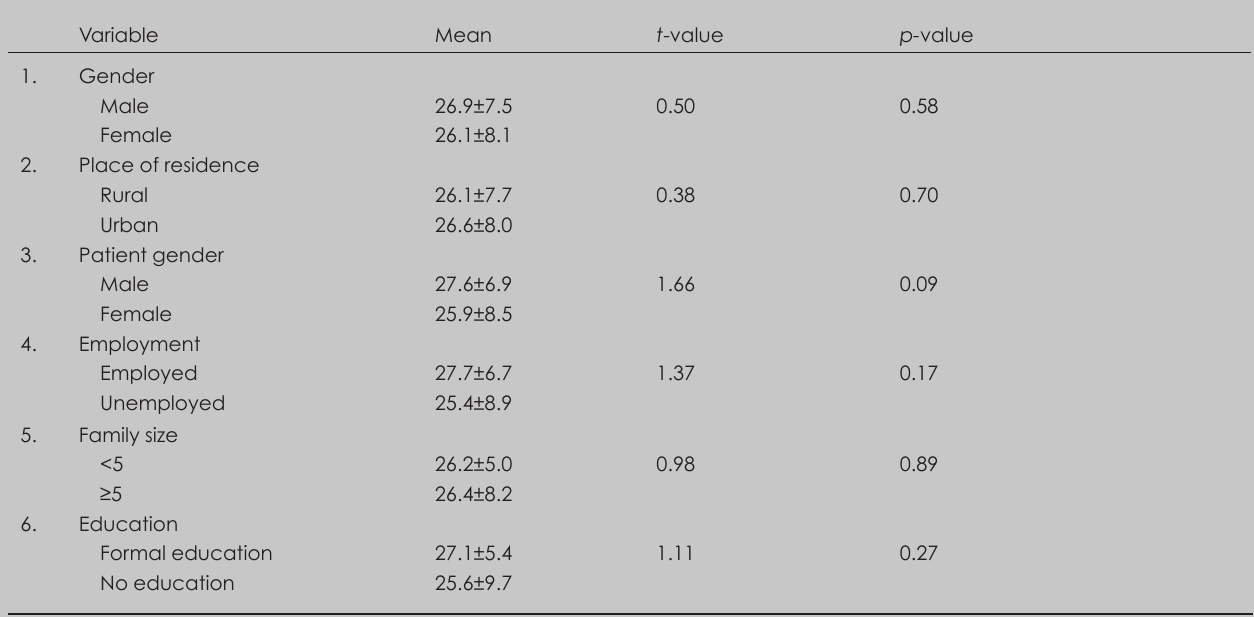
Table II. Mean scores of ZBI by socio-demographic characteristics of